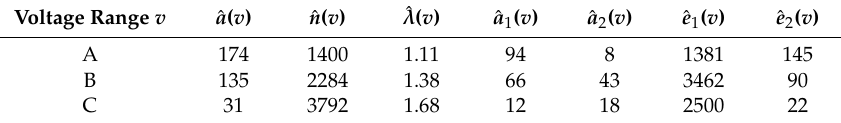
Table 5. Characterization of overloaded lines in the N − 1 condition.